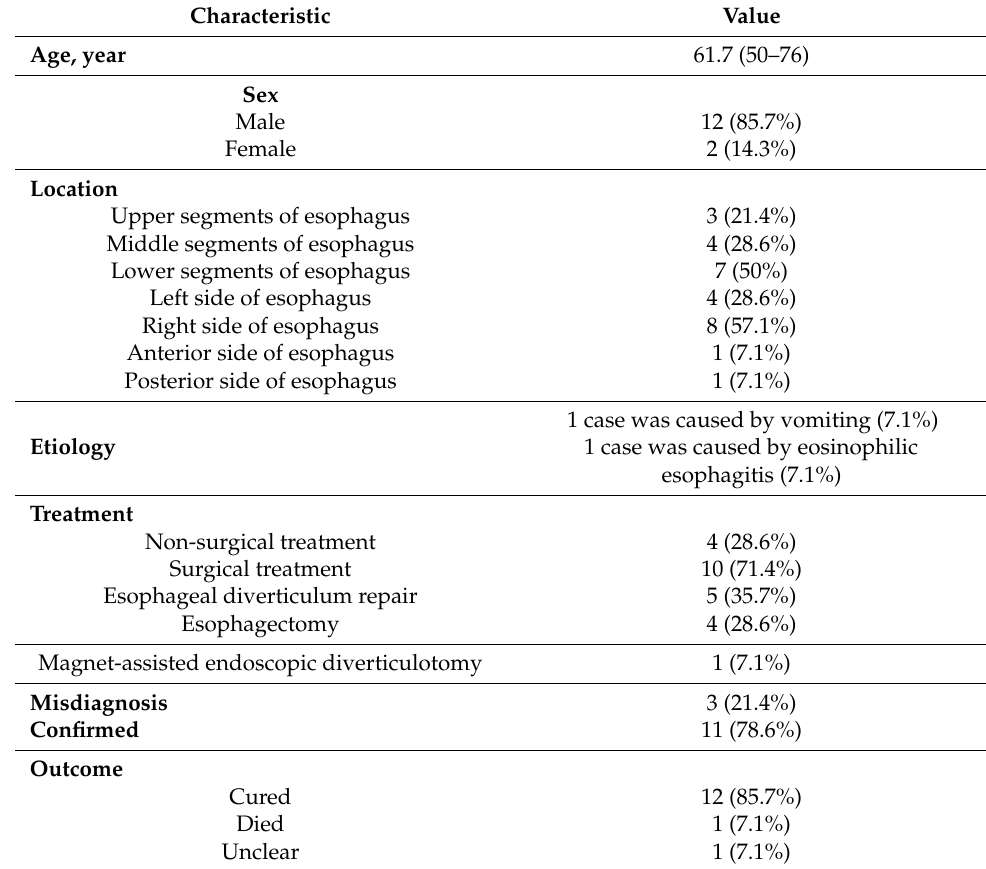
Table 2. Summary features of 14 patients with spontaneous rupture of esophageal